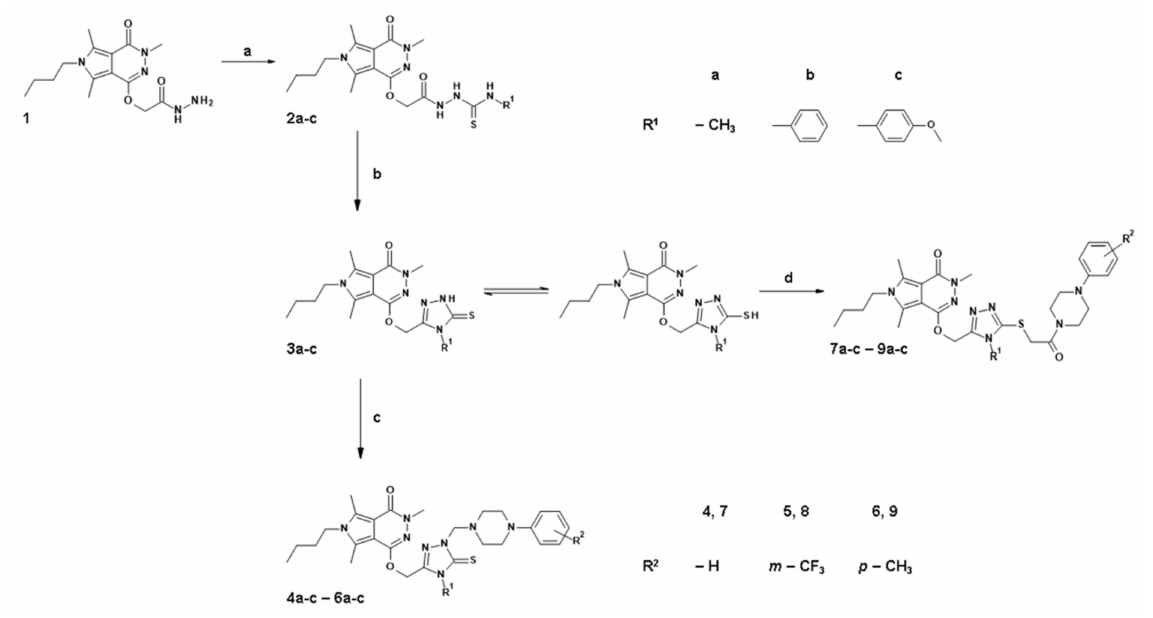
Scheme 1. Synthesis of the intermediates 2a-c-3a-c and the title compounds 4a-c-9a-c . Reagents and reaction conditions: ( a ) N substituted isothiocyanate, ethanol, reflux, 0.5–2 h; ( b ) I. 5% NaOH (aq), reflux, 2 h; II. Cooling, crushed ice, stirring, acidification with 7.5% HCl; ( c ) 37% HCHO, 4 aryl piperazine derivative, methanol, RT 5 h; ( d ) C 2 H 5 ONa, 1 (2-chloro-1- oxoethyl)-4-aryl piperazine derivative, ethanol, reflux, 5